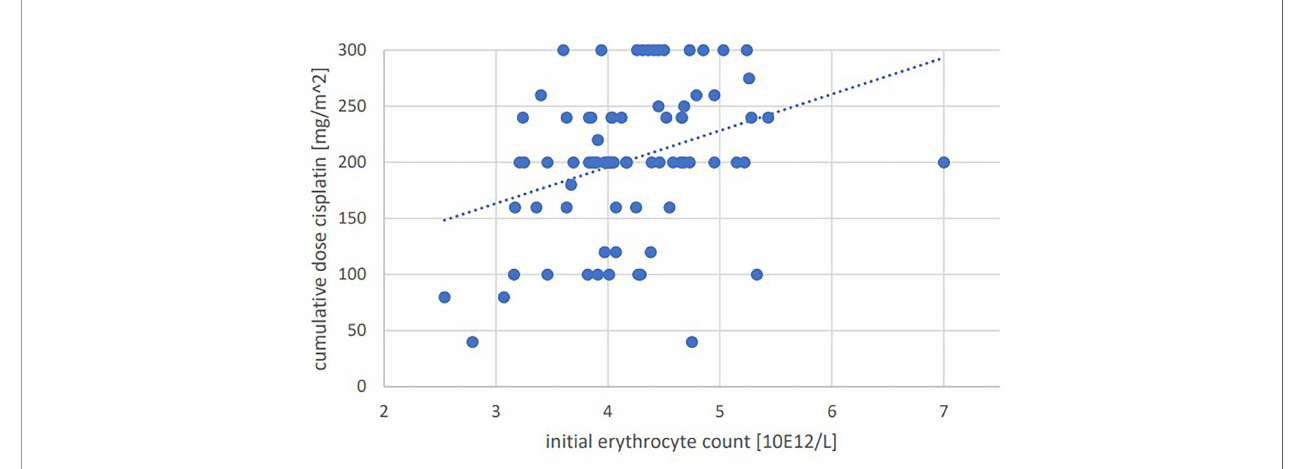
FIGURE 3 | Bivariate correlation analysis of initial erythrocyte count [10E12/L] with fi nal cumulative total dose of cisplatin achieved [mg/m^2]: p=0.002, Pearson ’ s r=0.337; individual values as points, dashed linear trend line.